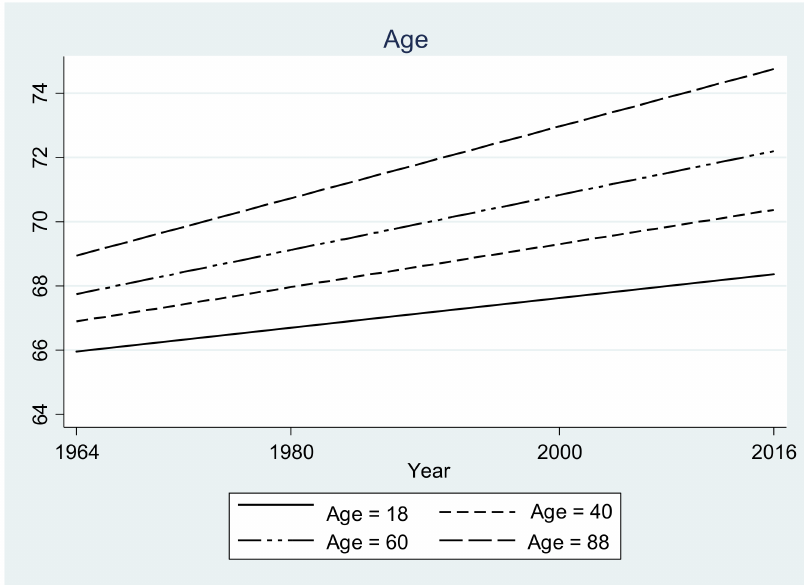
Figure 5. Impact of age on the Jewish feeling thermometer, 1964–2016. Based on results from Table 3. Source: American National Election Studies,